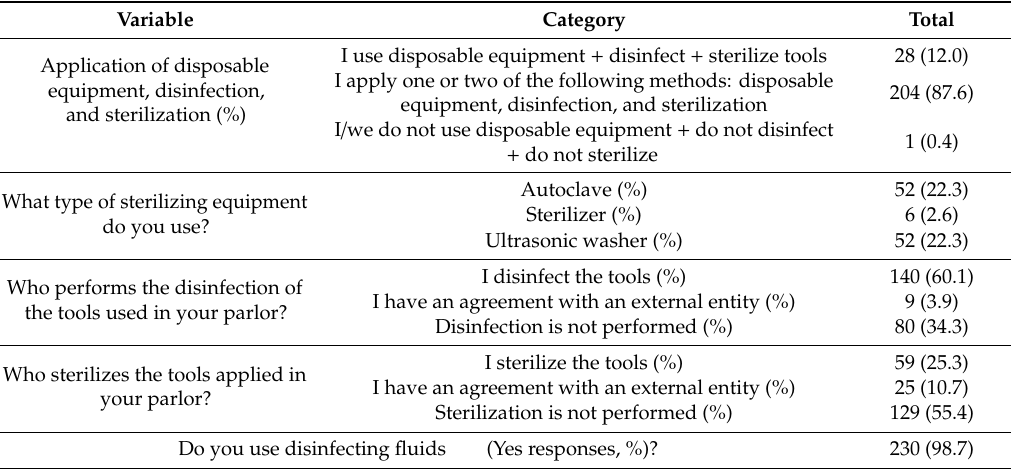
Table 6. Equipment, disinfection, and sterilization—detailed